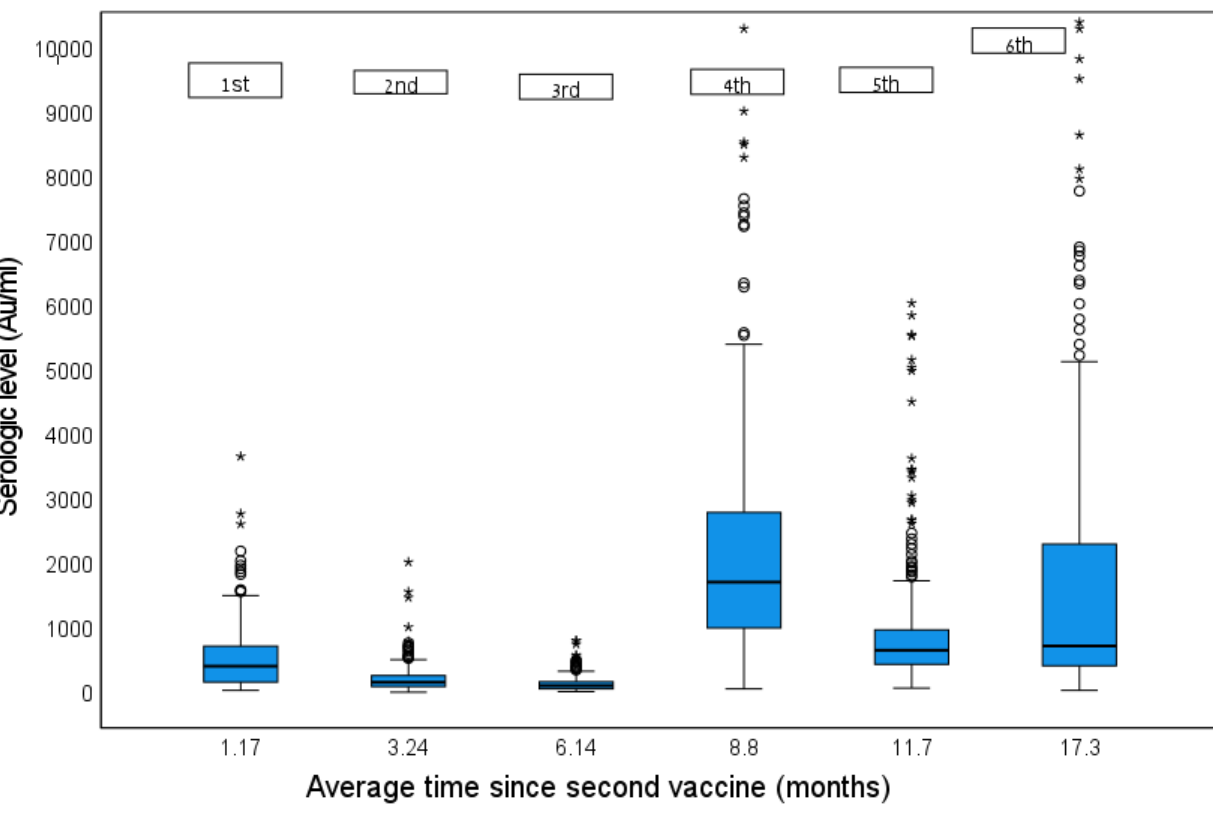
Figure 4. Serial serological tests among HCW who were negative for COVID-19 during the study period. Straight line represents the 3rd vaccine (Booster 1); Dashed line represents the 4th vaccine (Booster 2); * represents extreme outliers (data points); o represents mild outliers (data points) Table 3. Characteristics of participants who went through the 6th serology test in June 2022.